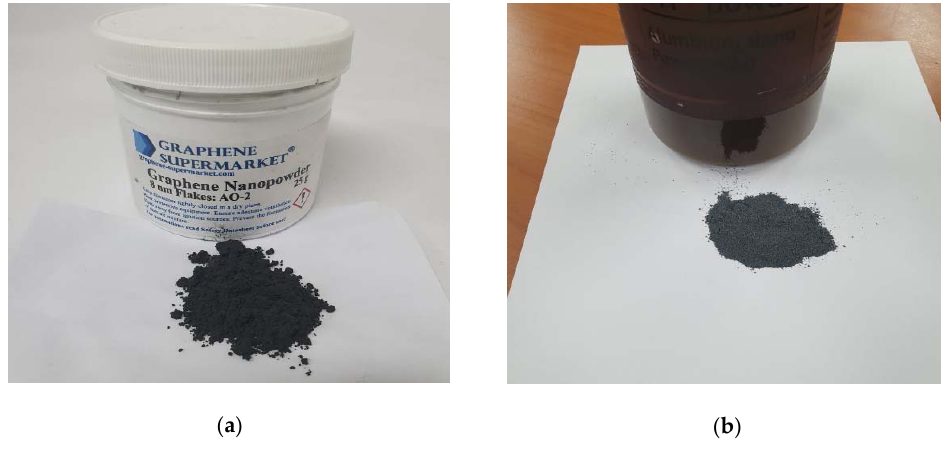
Figure 2. Photograph of nano powder: ( a ) graphene and ( b ) Al 2 O 3 . Table 1. Mixing conditions of copper nano powder.